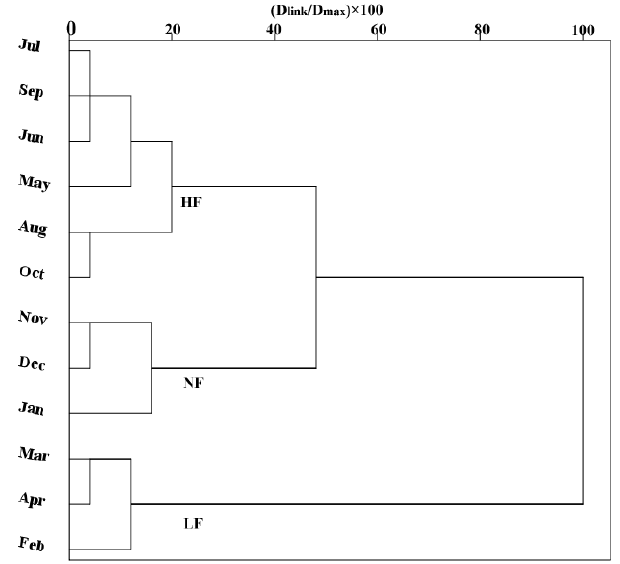
Figure 2. Dendrogram showing the temporal similarities of the monitoring periods produced through cluster analysis. Note: HF represents high flow period, NF represents normal flow period, LF represents low flow period.